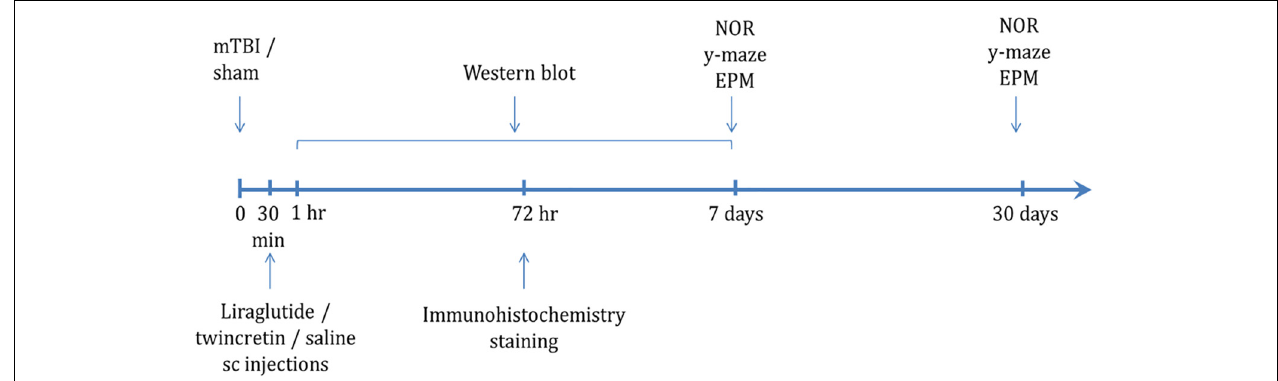
FIGURE 1 | Scheme of study design time line. Animals were exposed to sham/mTBI and 30 min later were given liraglutide (247.6 µ g/kg), twincretin (50 µ g/kg), or saline once daily via s.c. injections for 7 days {the human dose of liraglutide and twincretin is 1.8 mg s.c. daily that, for a 88.8 kg human [the mean weight of a male American (Yuan et al., 2017)], following normalization to body surface area across species in line with U.S. Department of Health and Human Services Food and Drug Administration guidelines (Han et al., 2016), translates to a mouse dose of approximately 247.6 µ g/kg}. Behavioral tests to assess behavior and cognitive abilities were carried out 7 and 30 days following mTBI in separate cohorts of animals. Immunohistochemical staining to evaluate neurodegeneration and neuroinflammation was performed 72 h following mTBI challenge. Western blot analysis to assess changes in neuroprotective protein levels following mTBI and drug treatments was performed starting from 1 h to 1 week post mTBI. Each experimental time point was performed using a different group of mice (NOR: novel object recognition paradigm; EPM: elevated plus maze